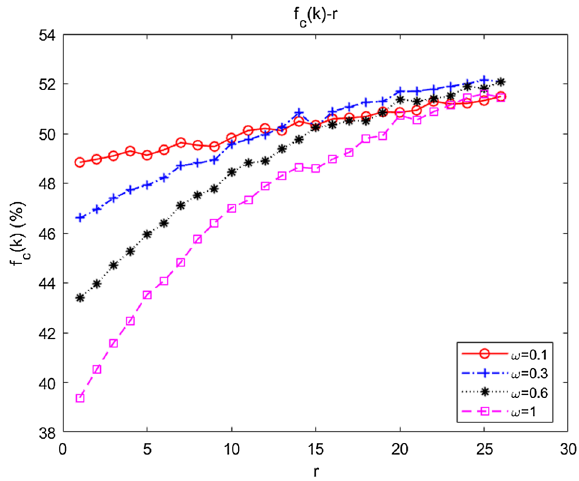
Figure 12. Relationship between average abundance and the multiplication factor.